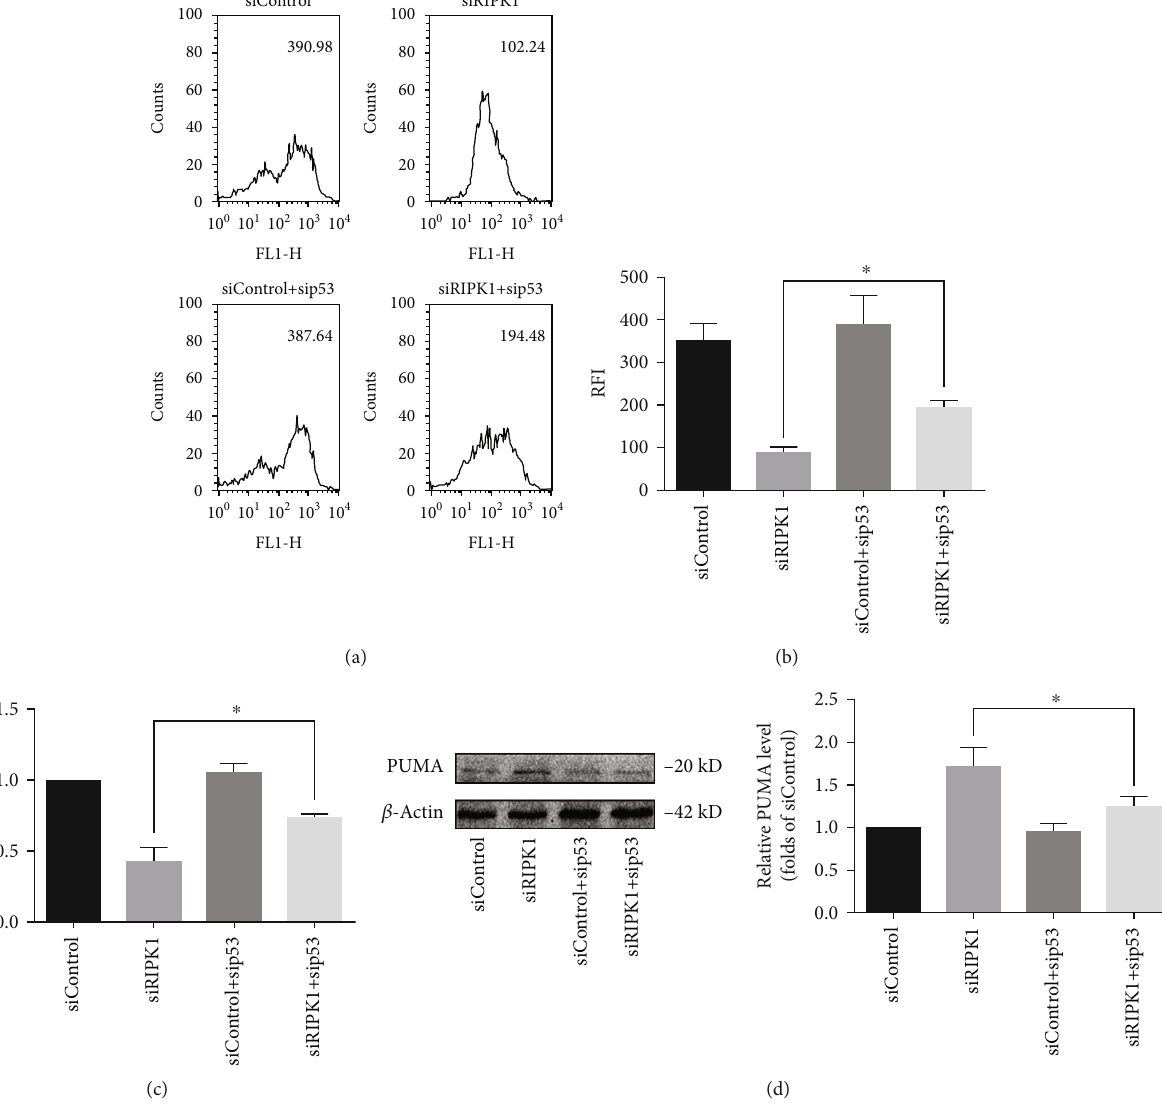
Figure 6: RIPK1 maintained mitochondrial homeostasis of bone marrow MSCs via p53. (a) Representative graphs illustrated that the increase of mPTP opening after knockdown of RIPK1 in bone marrow MSCs was signi fi cantly reversed by sip53. (b) The quantitative mPTP in bone marrow MSCs was demonstrated by RFI. Data are expressed as the means ± SD from three independent experiments ( ∗ p < 0 : 05 , vs. siRIPK1; n = 3 ). (c) The decrease of mitochondrial ATP production after knockdown of RIPK1 in bone marrow MSCs was signi fi cantly reversed by sip53. Values are expressed as the means ± SD from three independent experiments ( ∗ p < 0 : 05 , vs. siRIPK1; n = 3 ). (d) Representative western blots for the expression of PUMA. Histogram analysis showing the relative protein levels of PUMA. Data are presented as the means ± SD from three independent experiments ( ∗ p < 0 : 05 , vs. siRIPK1; n = 3